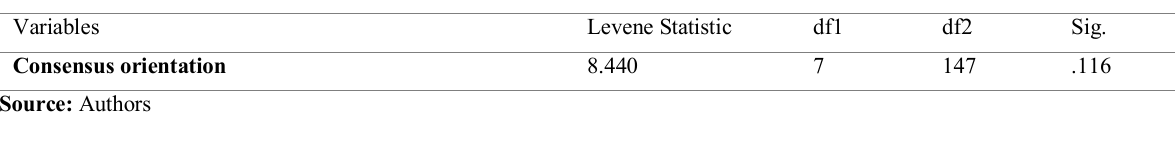
Table 8: Levene Statistic